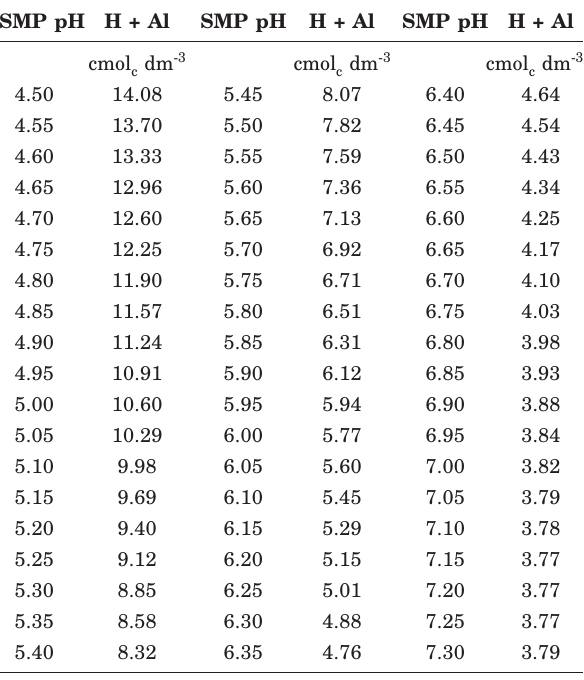
Table 1. Estimation of potential acidity (H + Al) versus SMP pH of soils of the State of